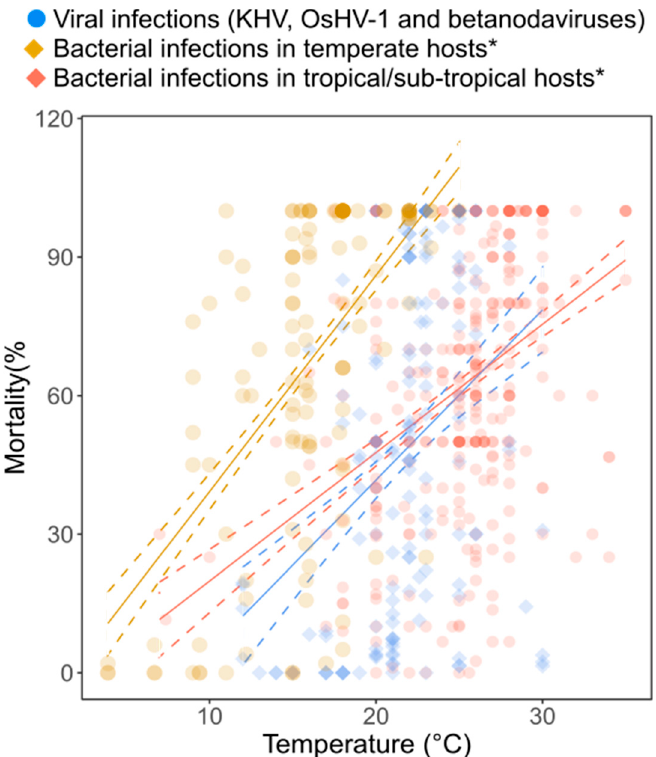
Figure 2. Predicted changes in mortality (%) of reared aquatic animals infected by bacteria * (yellow and red, * data previously published in Reverter et al. 2020) [6] and viral (blue, ostreid herpesvirus, koi herpesvirus and betanodaviruses) diseases in response to temperature. Dots display the raw data retrieved from research articles (n viruses = 160, n temp. bacteria = 129, n warm bacteria = 329). Solid lines represent the predicted mortalities according to selected linear and linear mixed models (Table 1), with dotted lines representing the 95% confidence interval for each of the models.